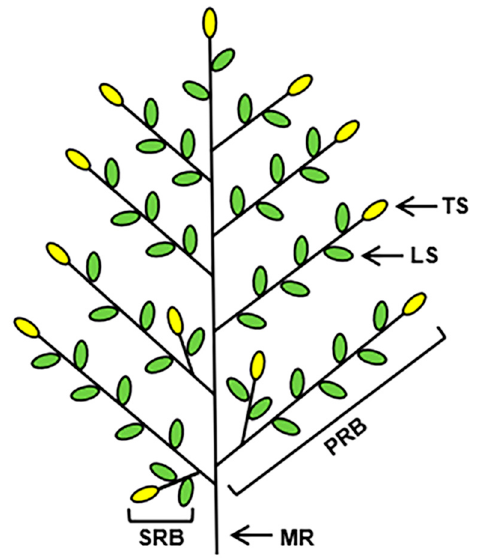
Figure 1. Panicle architecture of rice. The green ellipses show the lateral spikelets and the yellow ellipses show the terminal spikelets. LS, lateral spikelet; MR, main rachis; PRB, primary rachis branch; SRB, secondary rachis branch; TS, terminal spikelet.